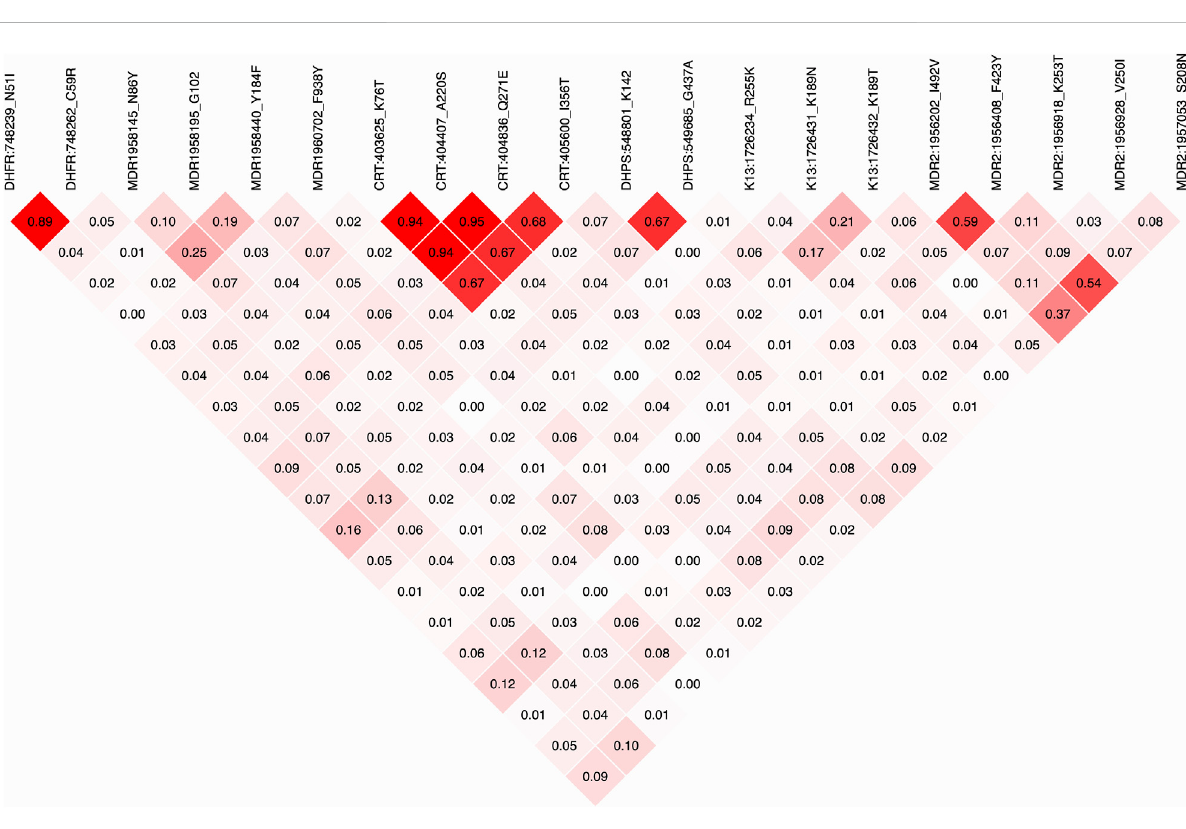
FIGURE 4 Heatmap of linkage disequilibrium (LD) between SNPs in drug resistance markers, labeled by gene name, genomic position, and amino acid allele. Each cell is color shaded by intensity of LD, with the r 2 value between the loci